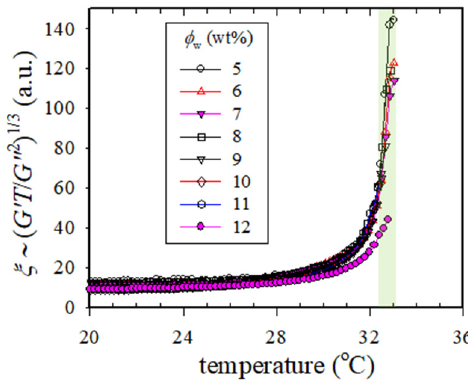
Figure 10. Plots of correlation length ξ versus T for the a-PNIPAM aqueous solutions with different concentrations. ξ theoretically diverges at T s,gel . The shaded area is the T s.gel range for the a-PNIPAM solutions with a concentration range of 5–12 wt%.